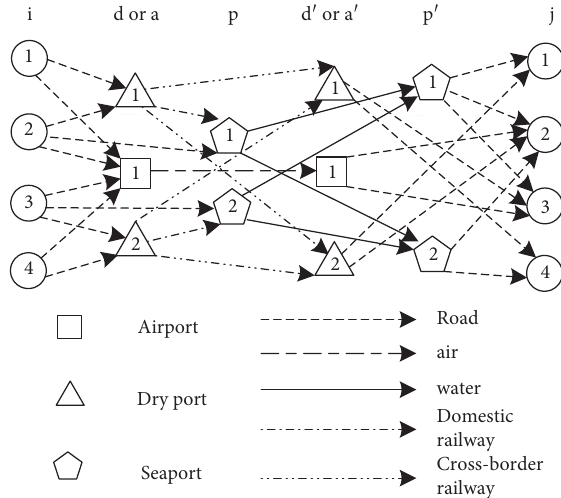
Figure 1: Abstract description of cross-border transportation problems.